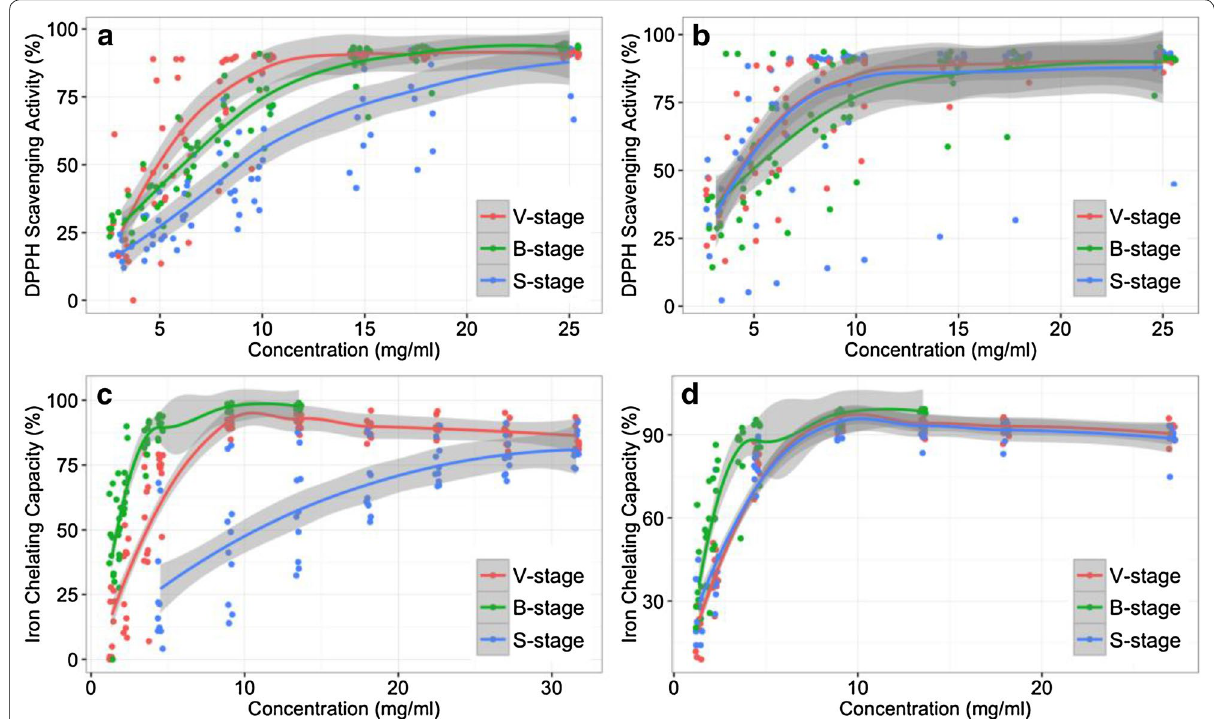
Fig. 2 Antioxidant activities of Baizhi root extracts from different growth stages. Baizhi roots were extracted with methanol, and extracts were diluted or concentrated to at least seven concentrations, and subjected to DPPH assay of taproot ( a ) and lateral root ( b ) and Fe 2 + chelating assay of taproot ( c ) and lateral root ( d ). The gray‑line zones indicate 95% confidence intervals for the loess regression line derived from ten plant samples for each